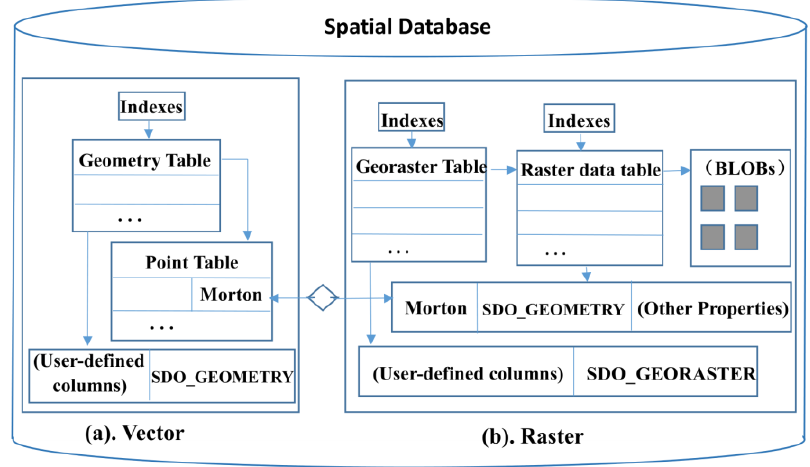
Figure 1. Data storage